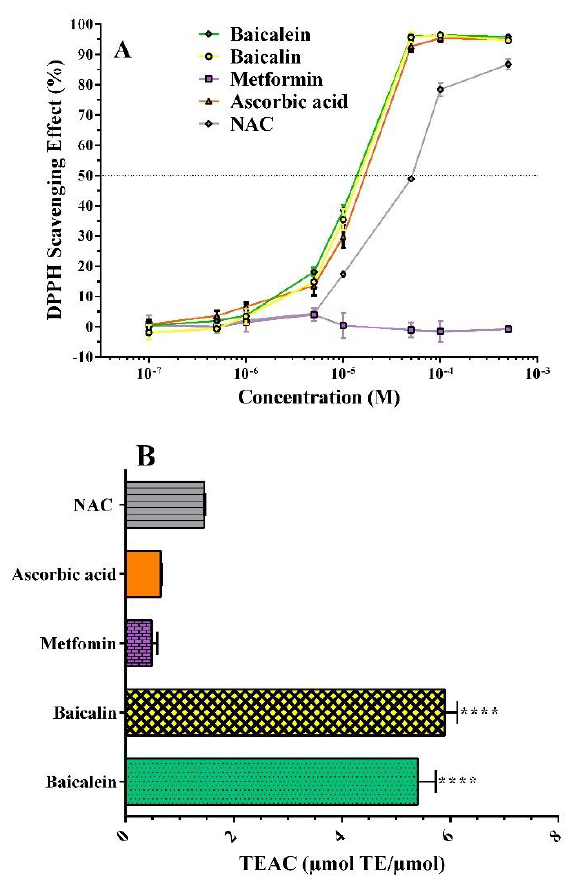
Figure 6. Antiradical activity of baicalein, baicalin, and metformin detected with DPPH • ( A ) and ORAC ( B ) assays. Positive controls: ascorbic acid and N –acetylcysteine (NAC). Data are the mean ± SEM of 3–6 experiments. **** p < 0.0001 versus positive controls. ORAC values are expressed as TEAC (trolox equivalent antioxidant capacity, µmol TE/ µmol compound).